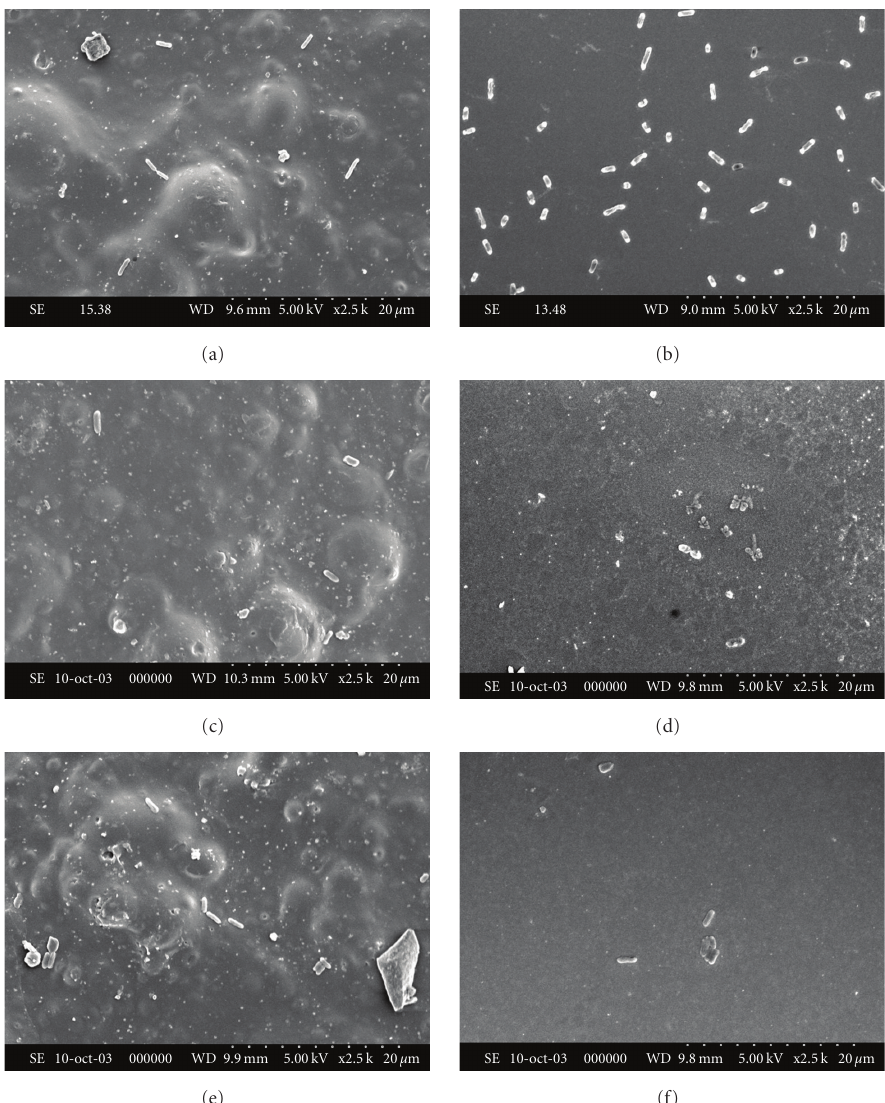
Figure 3: Attachment of Salmonella enteritidis to polystyrene ((a), (c), and (e)) and to glass ((b), (d), and (f)) at pH 6 ((a) and (b)), pH 7 ((c) and (d)) and pH 8 ((e) and (f)).